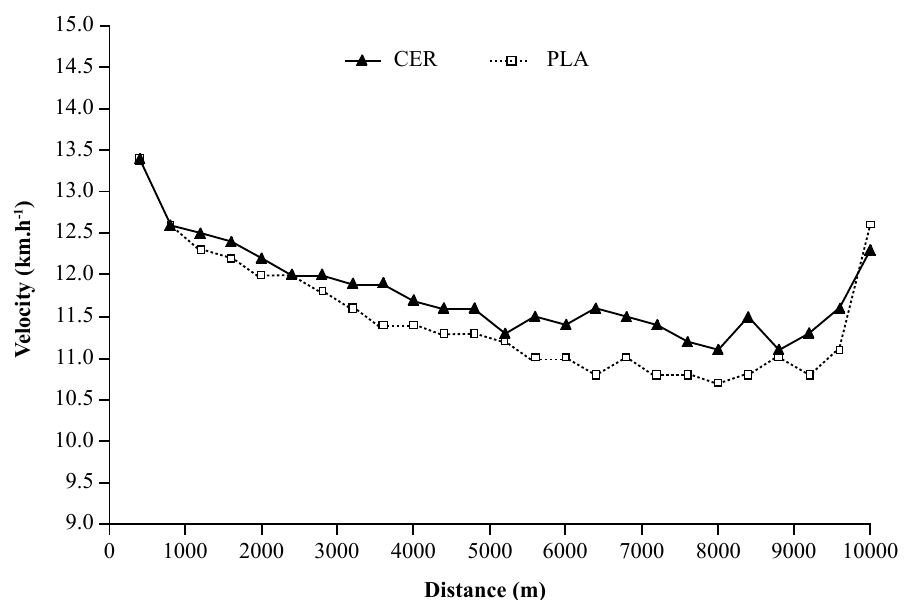
Figure 2. Mean velocity during the performance of 10 km, for PLA condition and CER condition.